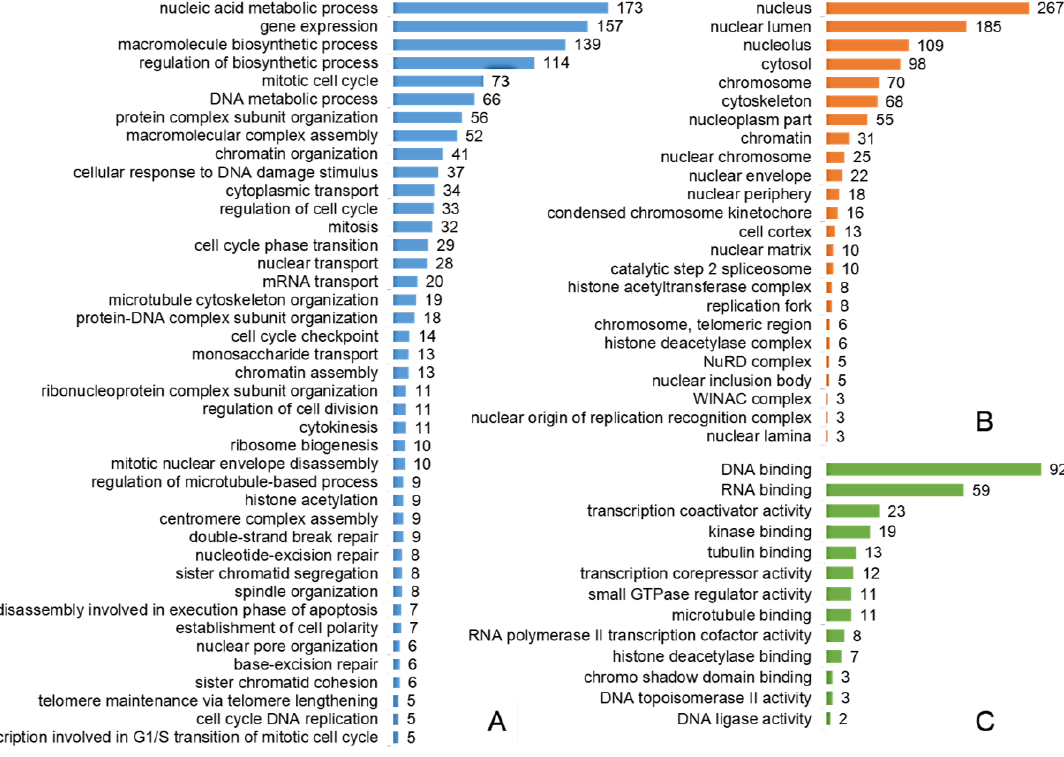
Figure 2. Selected results of Gene Ontology terms over-representation analysis (FDR <